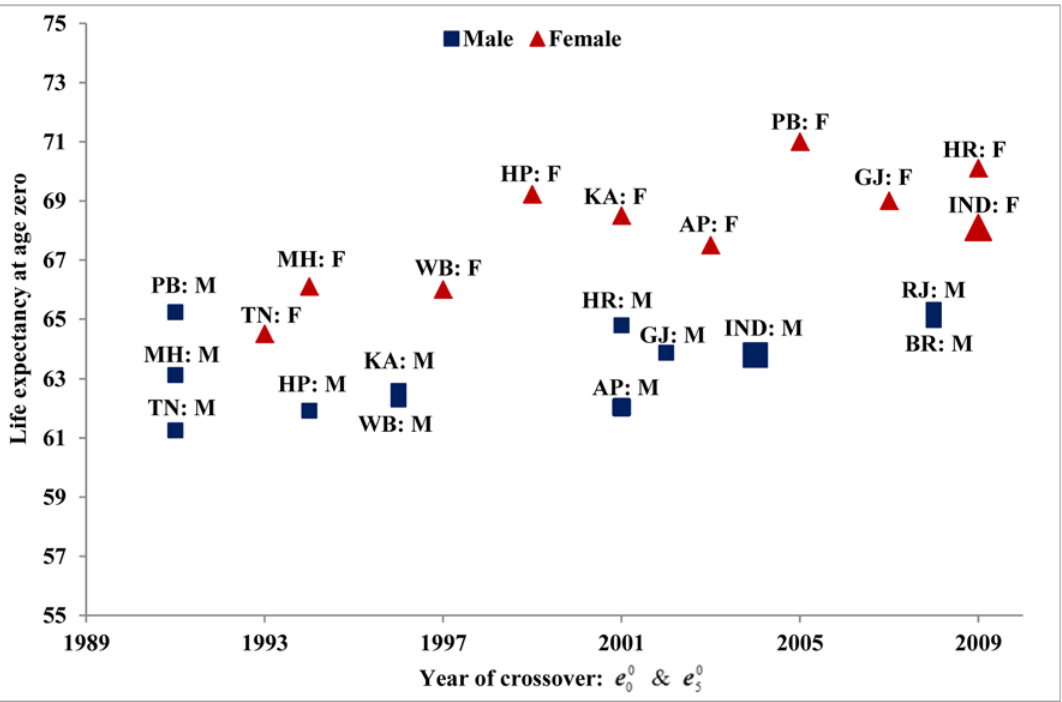
Fig 2. Levels of life expectancy at age zero at the time of crossover between life expectancies at ages zero and five, India and state, 1981 –